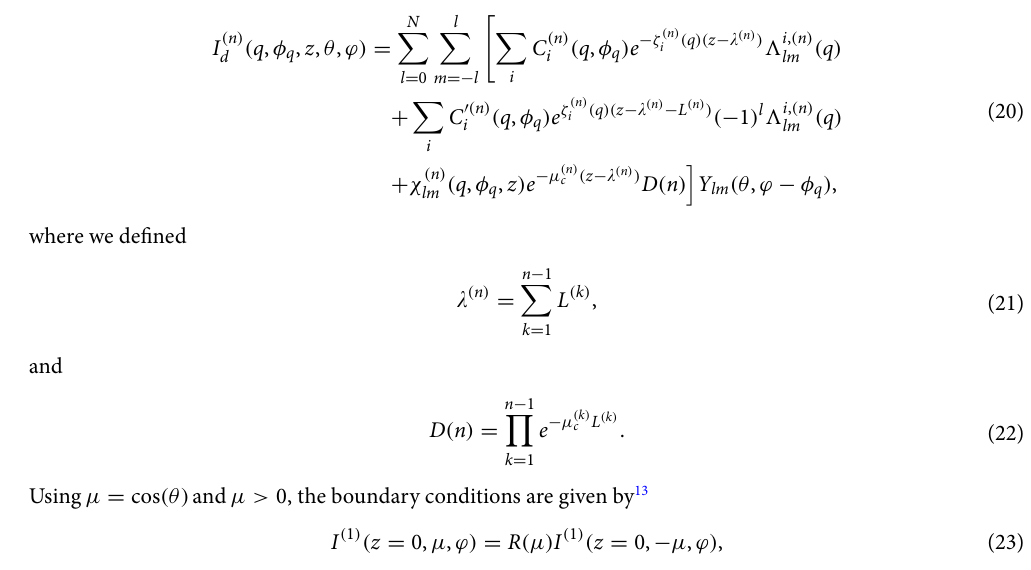
To that end, we first rescale the coefficients C i and C ′ i from equation (13) for each layer n ness L ( n ) and take the extinction and shift D ( n ) of the incident light by the layers above into account, resulting in